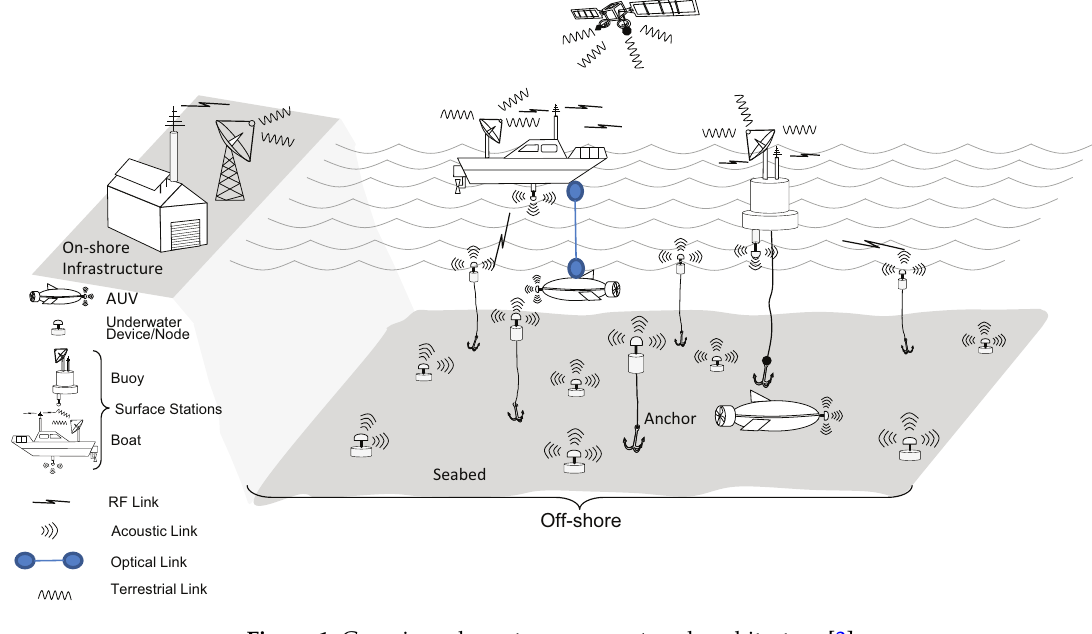
Figure 1. Generic underwater sensor network architecture [3]. Table 1. Underwater wireless communication